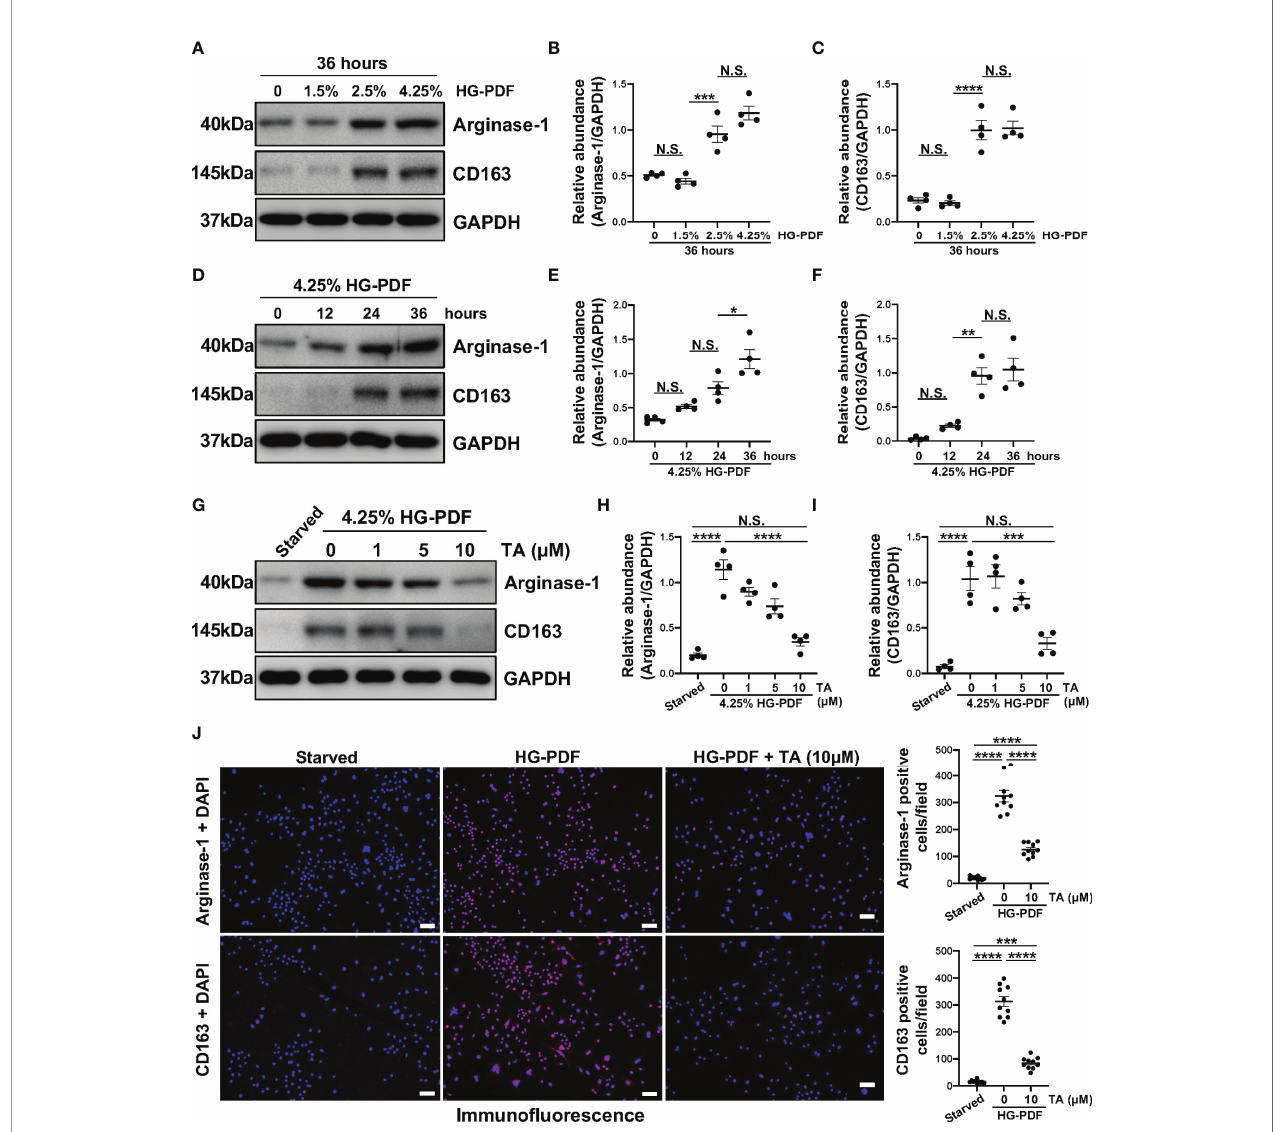
FIGURE 7 | TA inhibits M2 macrophage polarization in HG-PDF stimulated Raw264.7 cells. (A) Western blot analysis showed the levels of Arginase-1, CD163, and GAPDH in Raw264.7 cells treated with peritoneal dialysis fl uid in different dextrose concentrations. Expression levels of (B) Arginase-1 and (C) CD163 in different groups were quanti fi ed by densitometry and normalized with GAPDH. (D) Western blot analysis showed the levels of Arginase-1, CD163, and GAPDH in Raw264.7 cells treated with 4.25% HG-PDF for different times. Expression levels of (E) Arginase-1 and (F) CD163 in different groups were quanti fi ed by densitometry and normalized with GAPDH. (G) Western blot analysis showed the levels of Arginase-1, CD163, and GAPDH in 4.25% HG-PDF treated Raw264.7 cells with different doses of TA. Expression levels of (H) Arginase-1 and (I) CD163 in different groups were quanti fi ed by densitometry and normalized with GAPDH. (J) Representative micrographs of immuno fl uorescence staining of Arginase-1 and CD163 in Raw264.7 cells with different treatments. Quantization count of Arginase-1 and CD163 positive cells was calculated. Data were expressed as means ± SEM. *P<0.05, **P<0.01, ***P<0.001, ****P<0.0001. All scale bars = 50 m m. NS: P ≥